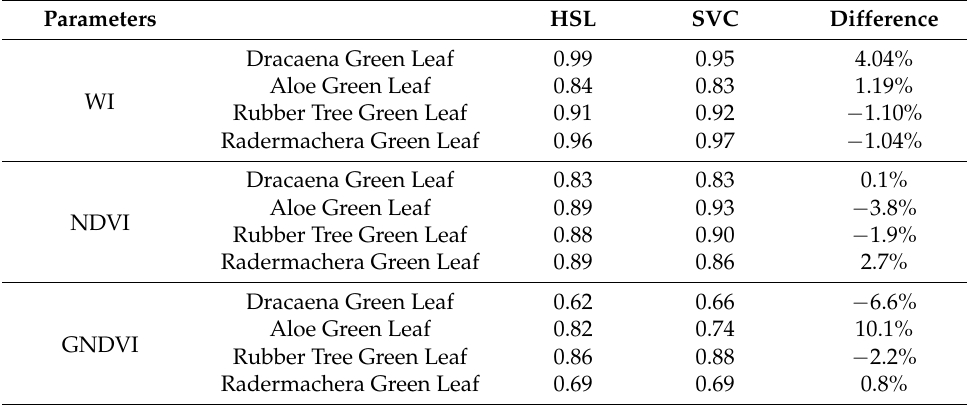
Table 3. Spectral indexes results